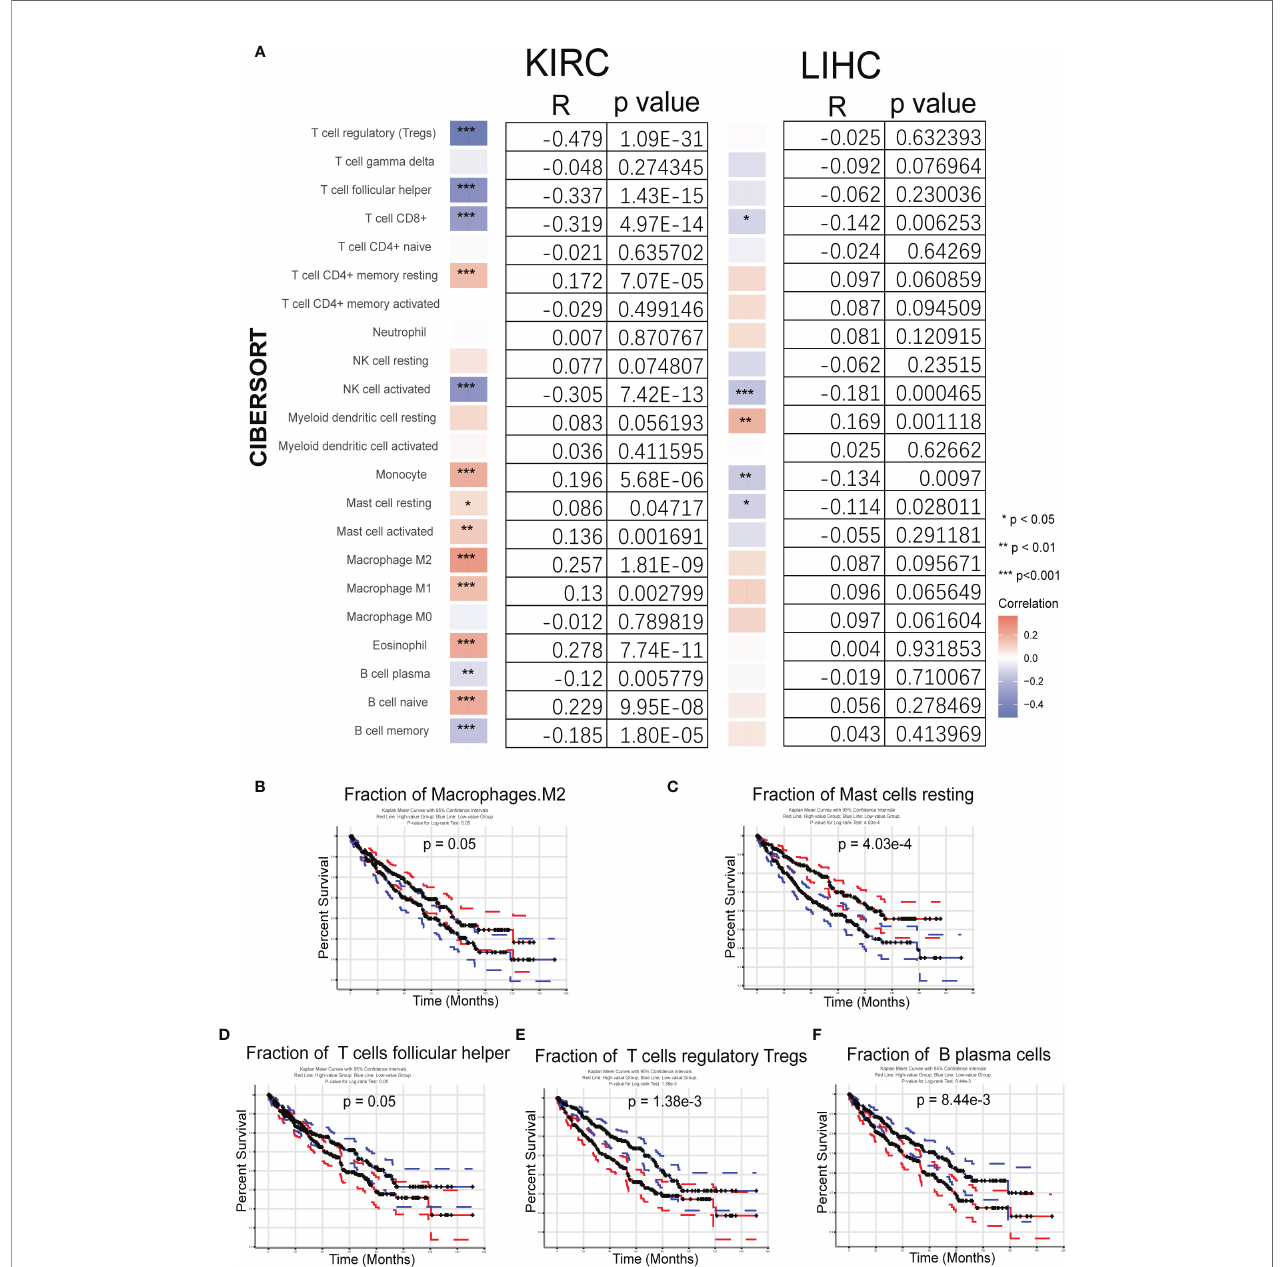
FIGURE 9 | Analysisofthefractionoftumor-in fi ltratingimmunecells(TIICs) inkidneyrenalclearcellcarcinoma(KIRC)andliver hepatocellular carcinoma(LIHC). (A) Correlation between22tumor-in fi ltratingimmunecellsand Gmfb expressioninKIRCandLIHCsamplesfrom TheCancer GenomeAtlas(TCGA). (B – F) Kaplan – Meier survivalcurves forTIICs onoverallsurvival. (B) Macrophages M2, (C) resting mastcells, (D) Thelpcells, (E) regulatoryTcells(Tregs), and (F) plasmacells.*p<0.05, **p<